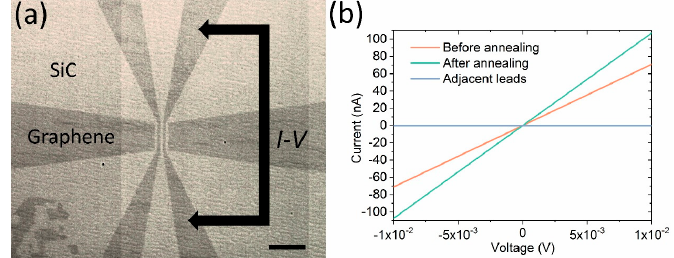
Figure 2. Thermal stability of graphene electrodes. ( a ) The optical microscope image of the G/SiC electrode with width (length) 1 μ m (10 μ m). Scale bar: 10 μ m; ( b ) The linear current-voltage (I-V ) characteristics of the G/SiC lead marked by arrows in (a) before and after annealing at T = 800 ° C. The adjacent leads are insulated before and after annealing and the resistance of the G/SiC lead decreased after the T = 800 ° C annealing.